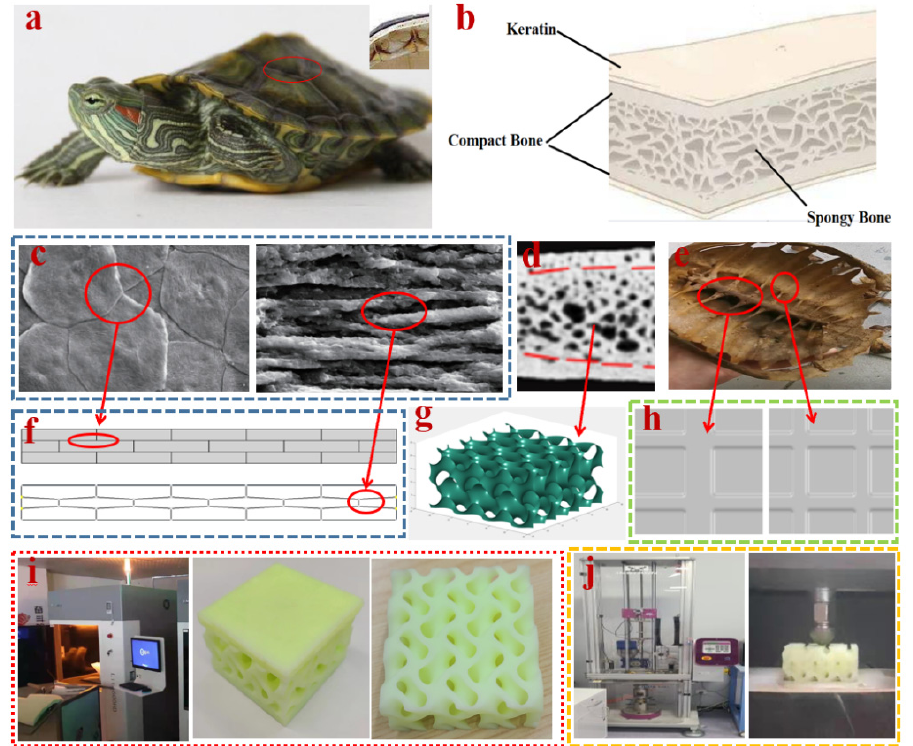
Figure 1. Bionic schematic diagram of a turtle carapace. ( a ) The partial enlargement of the turtle carapace. ( b ) The microscopic structure of the tortoise carapace. ( c ) The microstructure of keratin [29]. ( d ) The microstructure of the spongy bone region. ( e ) The turtle’s spine. ( f ) Plate. ( g ) Core. Structure from MATLAB. ( h ) Backplate structure. ( i ) The 3D printed composite structural specimens. ( j ) Drop-weight impact experiment.